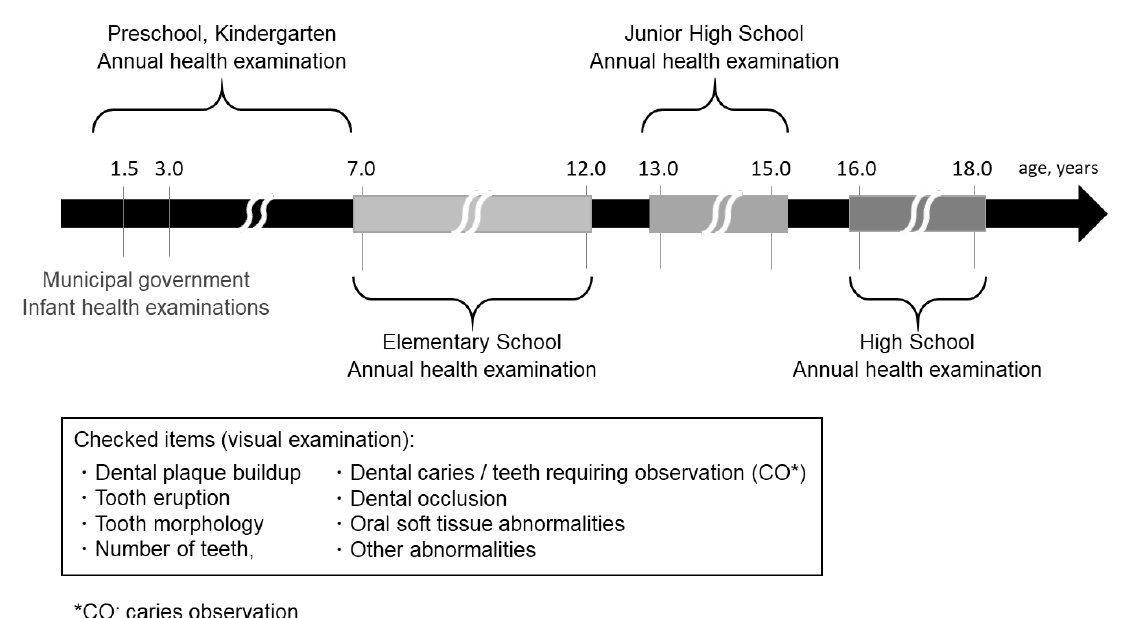
Figure 6. Health examination system for children in Japan .